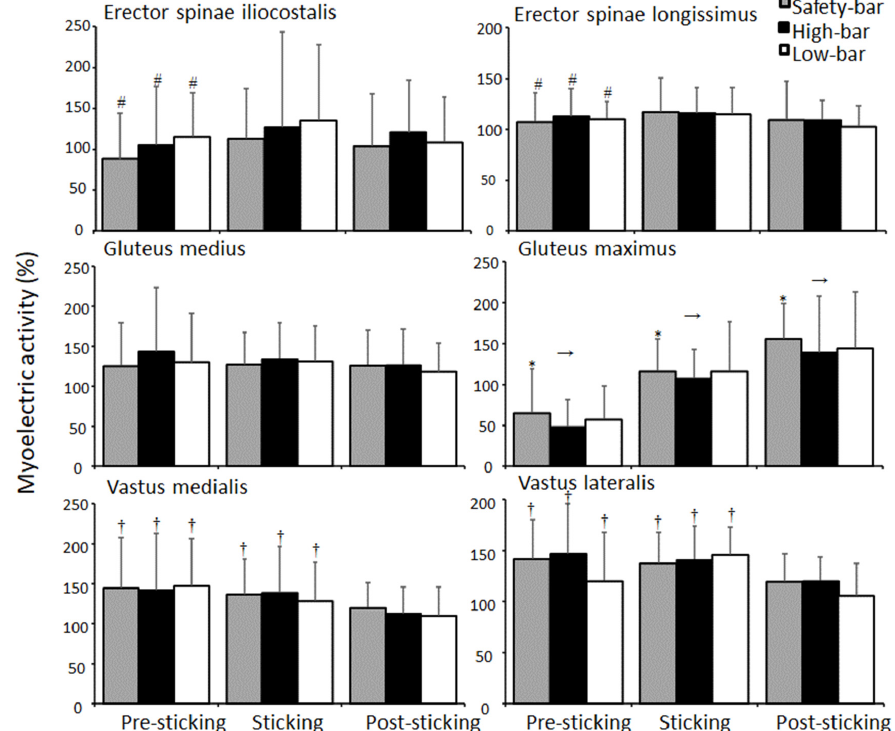
Figure 7. Mean ± SD normalised myoelectric activity for erector spinae iliocostalis, erector spinae longissimus, gluteus medius, gluteus maximus, vastus medialis and vastus lateralis during pre-sticking, sticking, and post-sticking region for the high-bar, low-bar, and safety-bar squat during 3-RM. # indicates a significant difference between the pre-sticking and sticking region for all squat conditions on a p ≤ 0.05 level. * indicates a significant difference between this squat condition and the high-bar condition on a p ≤ 0.05 level. → indicates a significant difference between this region and all other regions for all squat conditions on a p ≤ 0.05 level. † indicates a signi fi cant di ff erence between this region and the post-sticking region for all squat conditions on a p ≤ 0.05 level.